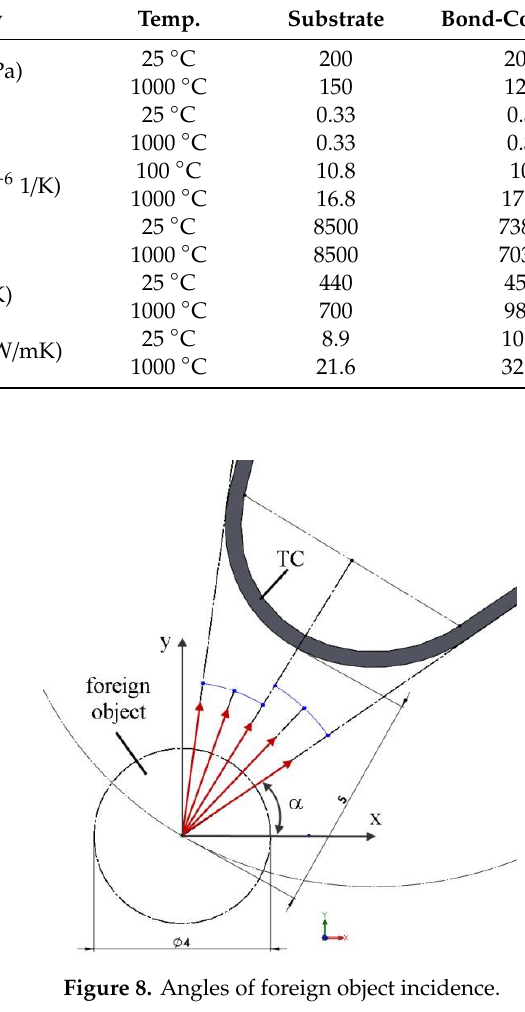
Table 3. Material data [29]. YSZ: yttria-stabilized zirconia.